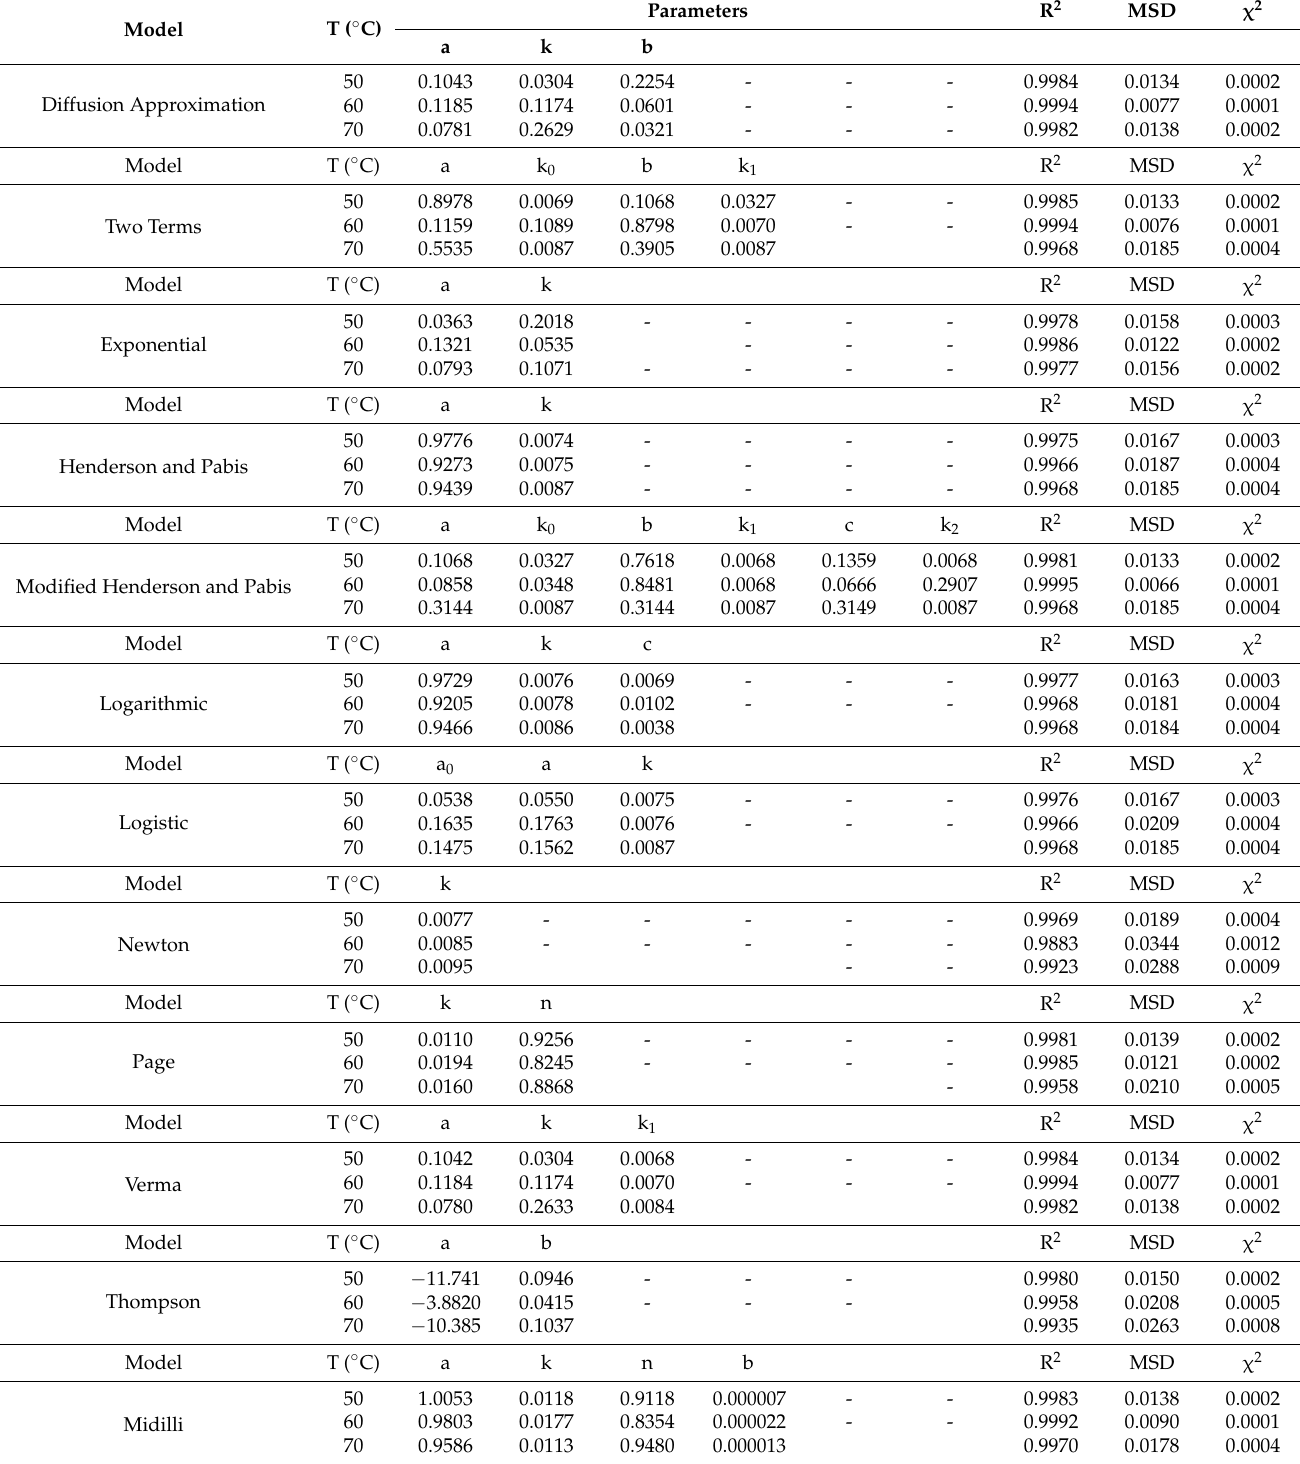
Table 3. Parameters of the models adjusted to the drying data of pomegranate peel flour at tempera- tures of 50, 60 and 70 ◦